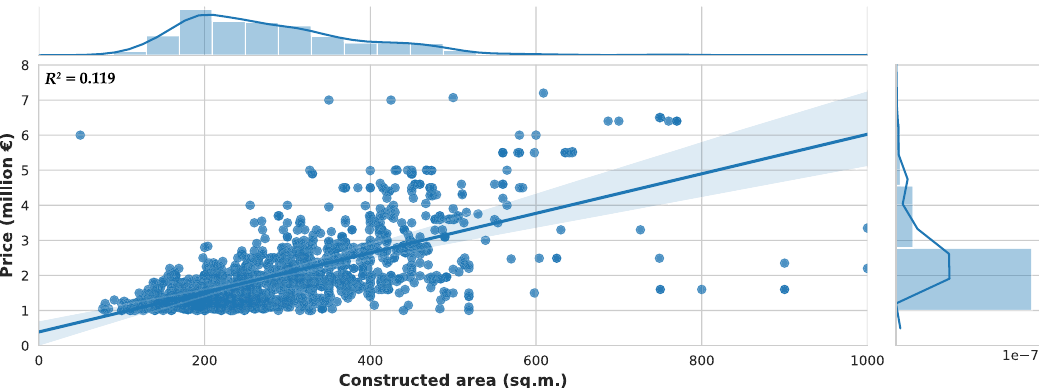
Figure 7. Linear regression between the constructed area and the asset